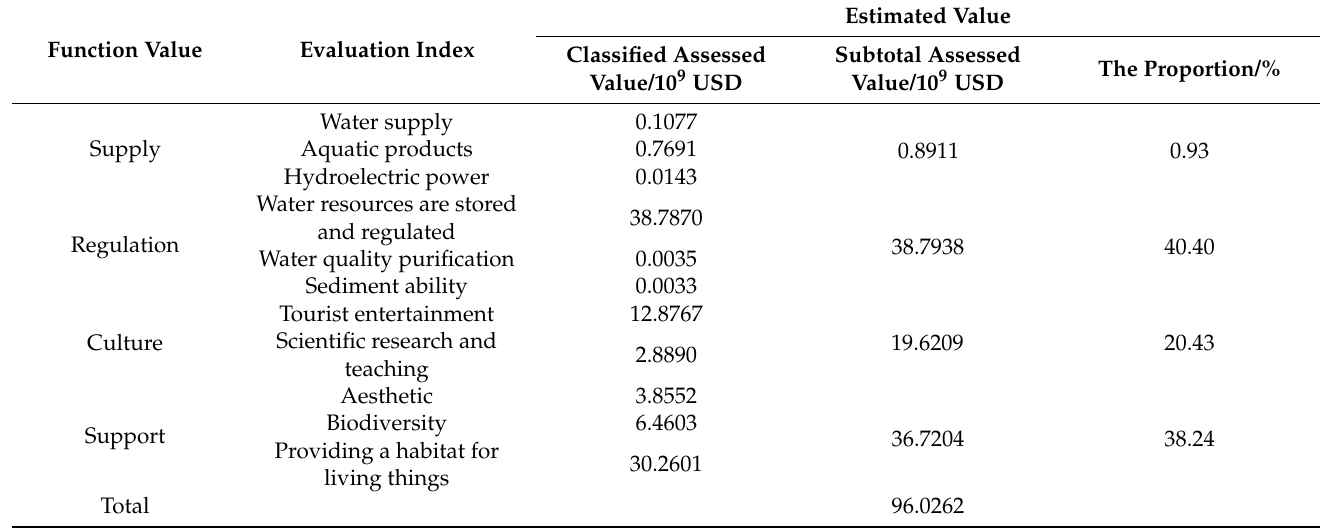
Table 5. Calculation results of ecosystem service value of the Tarim River